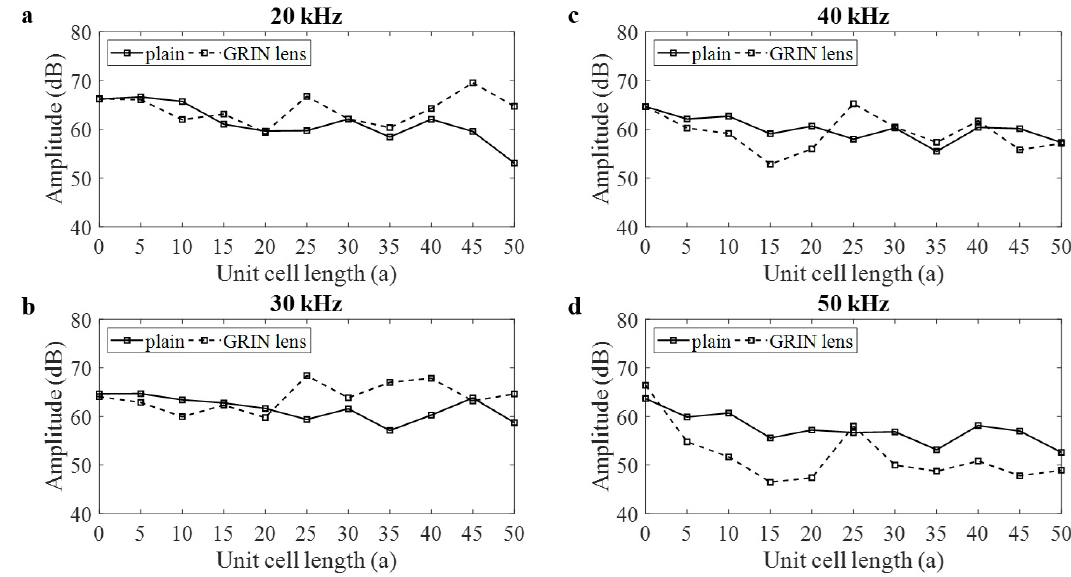
Figure 7. ( a ) Attenuation curves at 0° with and without lens for 20 kHz, ( b ) 30 kHz, ( c ) 40 kHz, ( d ) 50